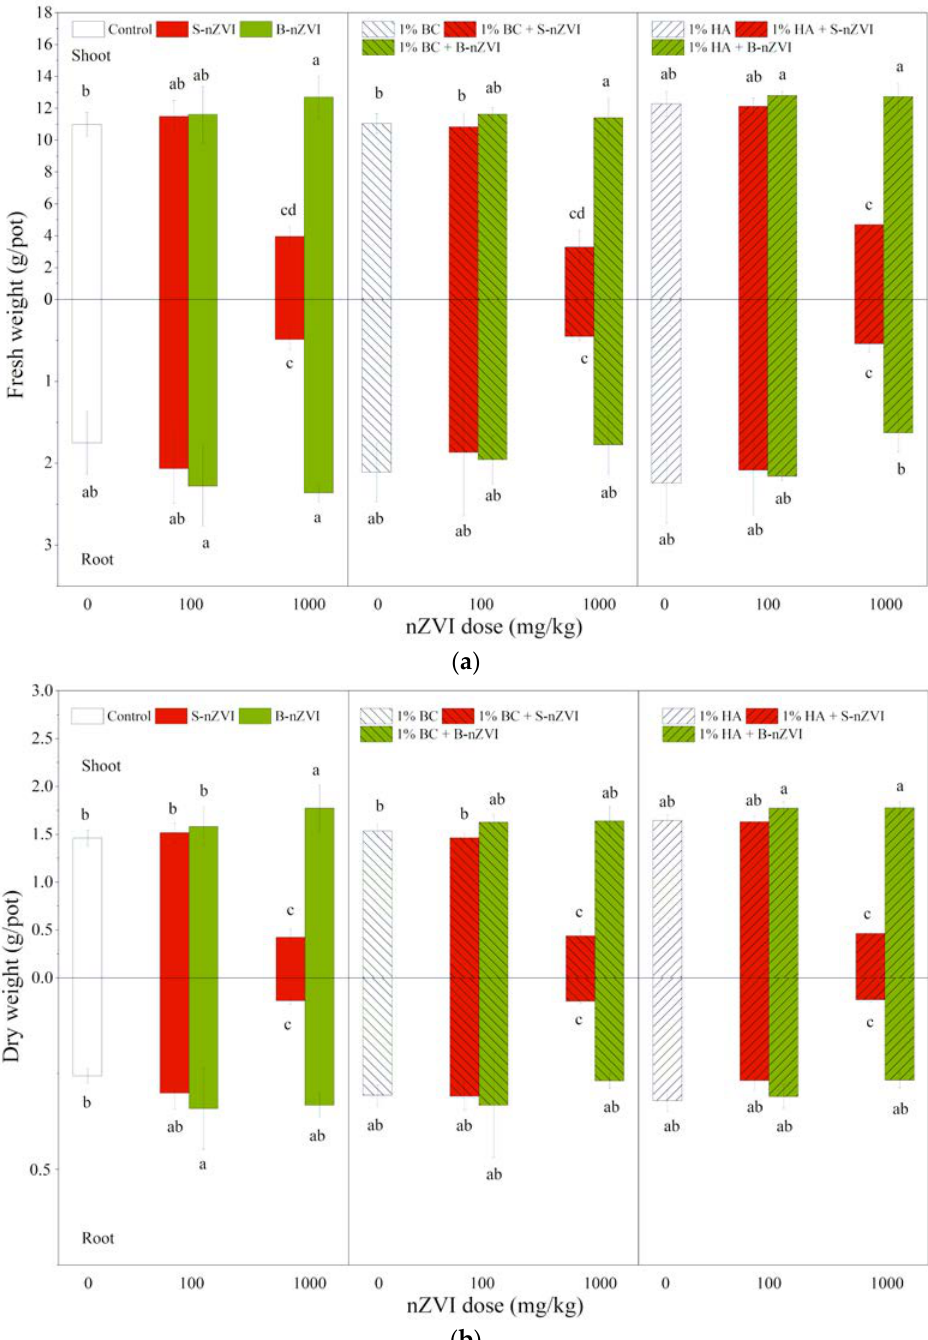
Figure 4. Shoot (above X-axis) and root (below X-axis) fresh ( a ) and dry ( b ) weights (means ± SD, n = 4) of mung bean seedlings exposed to nZVI alone or in combination with BC or HA. Different letters on the bars indicate significant differences among all means in different treatments using a one-way ANOVA followed by a Duncan’s multiple range test ( p < 0.05). Three-way ANOVA results are shown in Table 2.